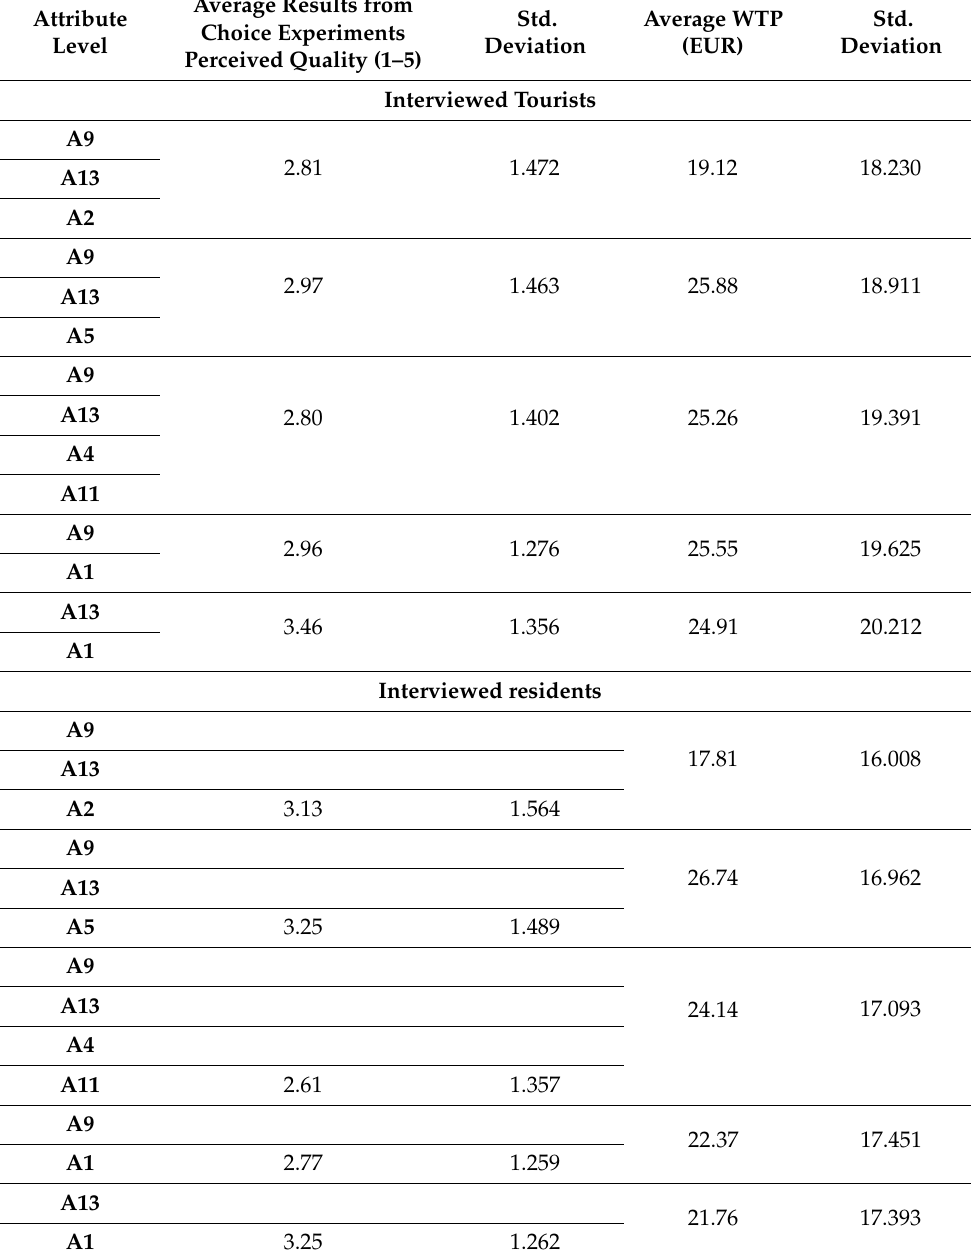
Table 6. Choice experiments and direct willingness to pay (WTP) related to attribute